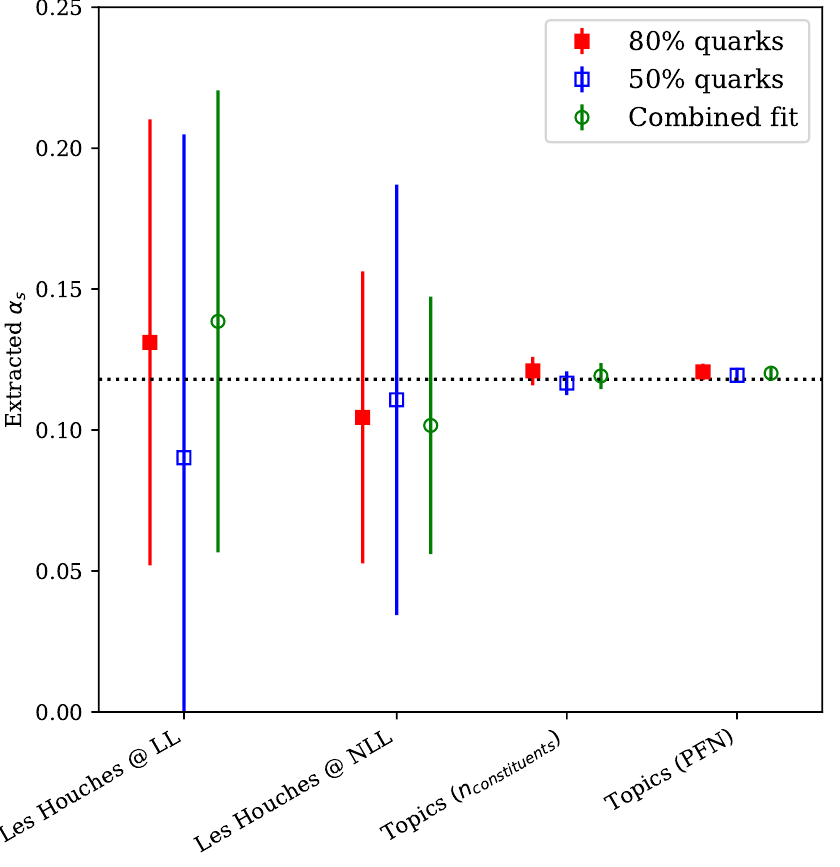
Figure 6 . Value of α S obtained following the methodology of ref. [11] with theoretical predictions at leading-logarithmic and next-to-leading-logarithmic accuracy and no a priori knowledge of the quark/gluon fractions, compared to the value obtained using next-to-logarithmic theory and flavor composition information obtained with the jet topics